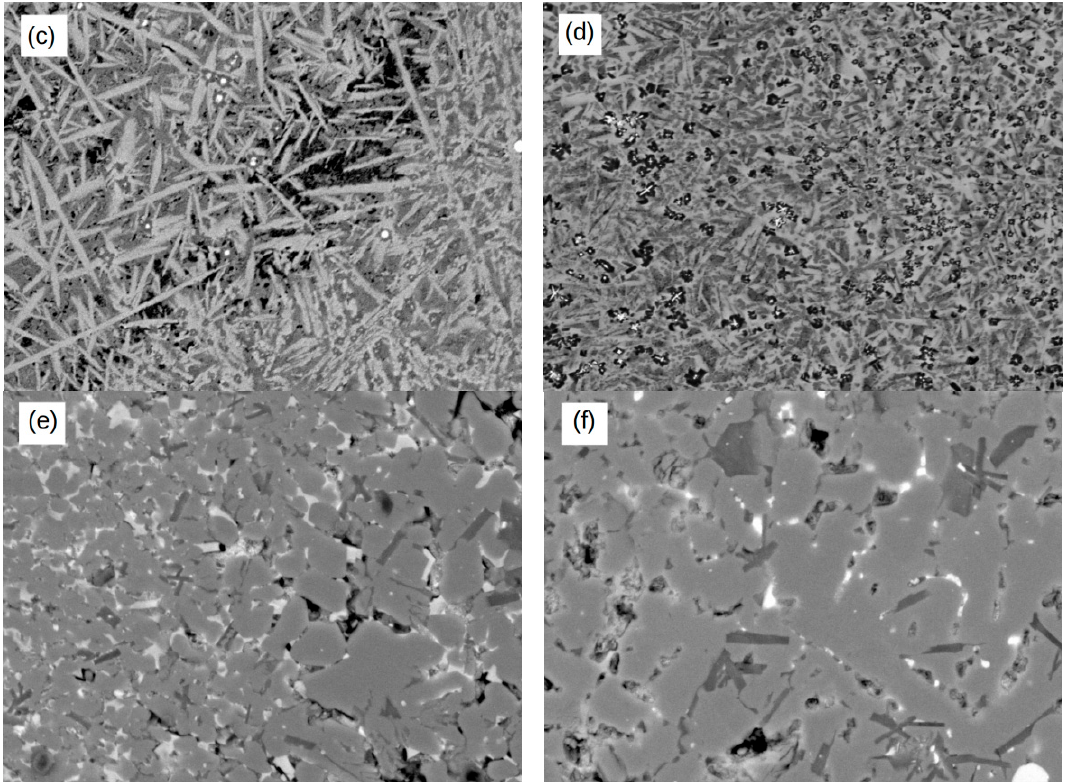
Figure 2. SEM images (BSE mode) for [(Fe 80 Nb 6 B 14 ) 0.88 Dy 0.12 ] 1 − x Zr x . ( a ) x = 0; ( b ) x = 0.02; ( c ) x = 0.05; ( d ) x = 0.1; ( e ) x = 0.2; ( f ) x = 0.3.